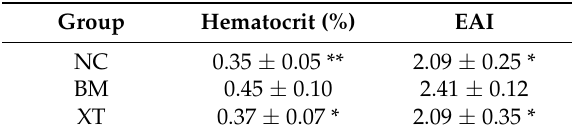
Table 2. Effects of XXT on hematocrit and EAI in rats with